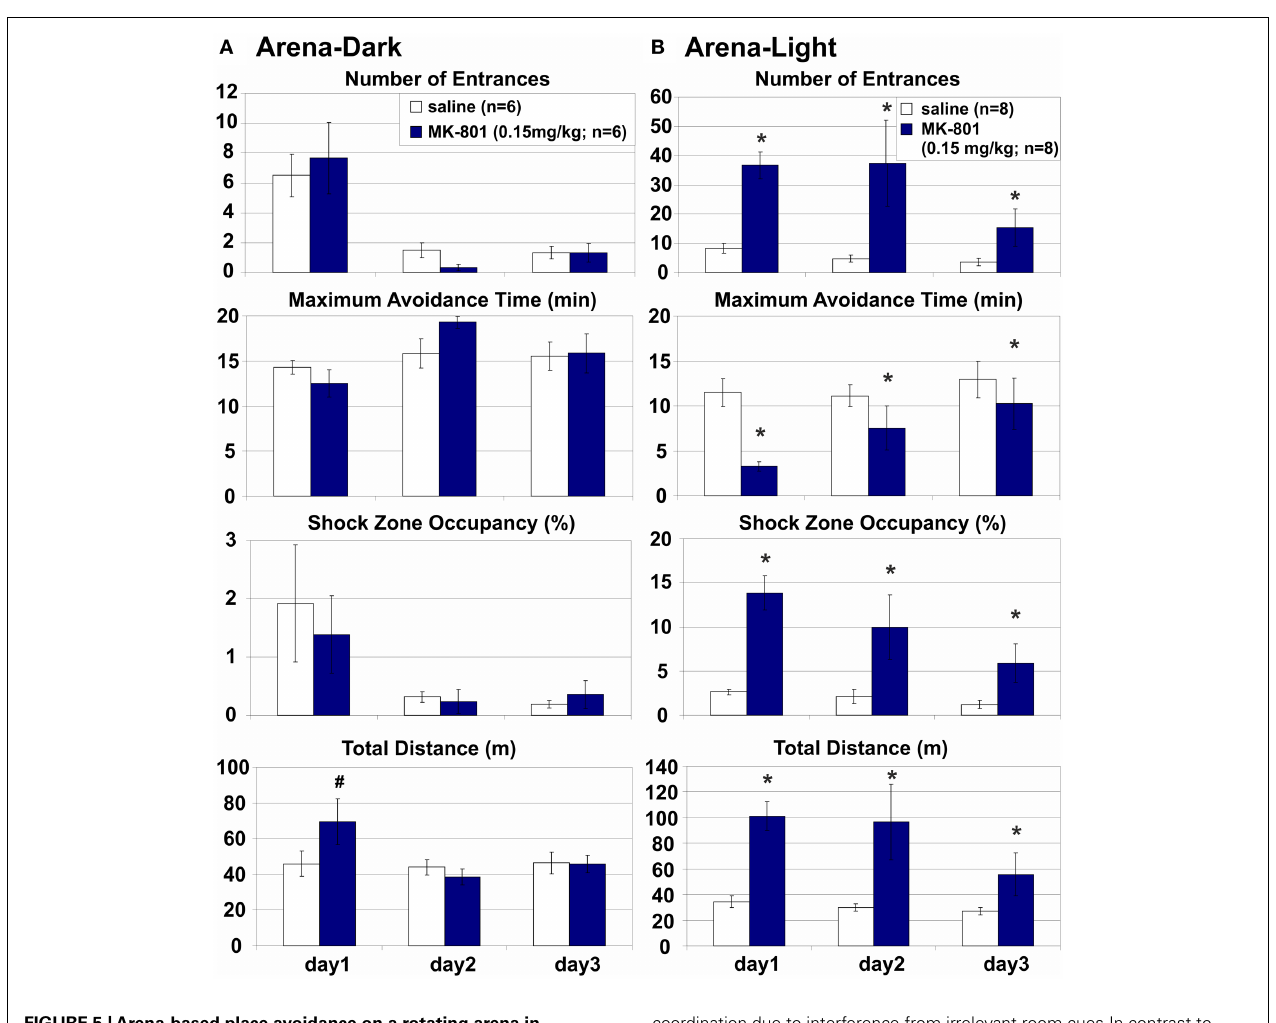
FIGURE 5 |Arena-based place avoidance on a rotating arena in Darkness and in Light . (A) Arena-Dark place avoidance posed no demand for coordination because the irrelevant room stimuli were hidden by darkness. MK-801 transiently increased locomotion in Darkness on day 1. (B) Arena-Light place avoidance with high demand for